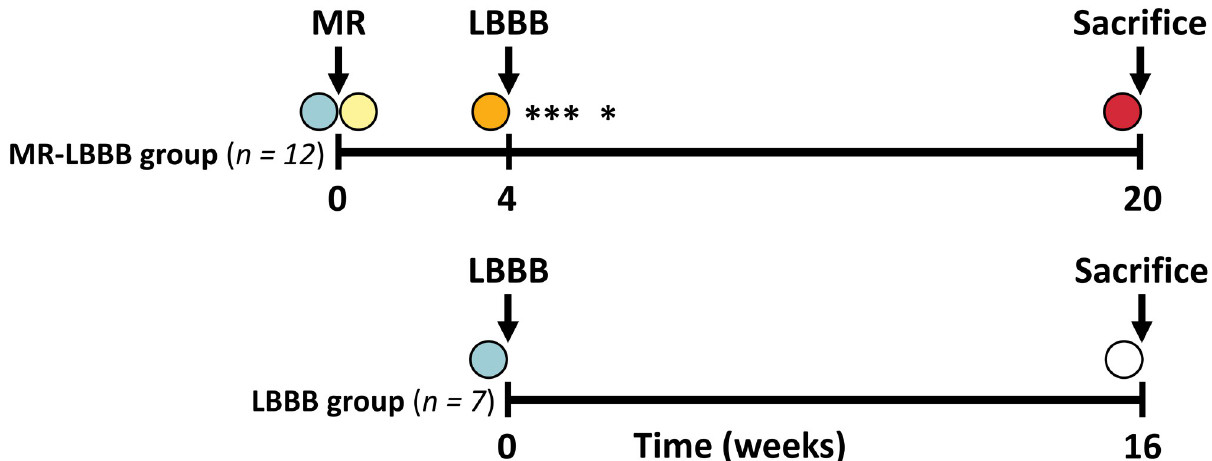
Fig 1. Timeline schematic of the canine experiments. MR-LBBB model: Creation of mitral regurgitation after baseline followed by LBBB induction after 4 weeks. LBBB model: LBBB induction after baseline. Circles indicate the time points of echocardiographic and hemodynamic measurements at baseline (blue), acute MR (yellow), 4 weeks (yellow), 16 weeks (white) and 20 weeks (red). The asterisks in the MR-LBBB group indicate death due to heart failure, all within 6 weeks. MR = mitral regurgitation; LBBB = left bundle branch block.